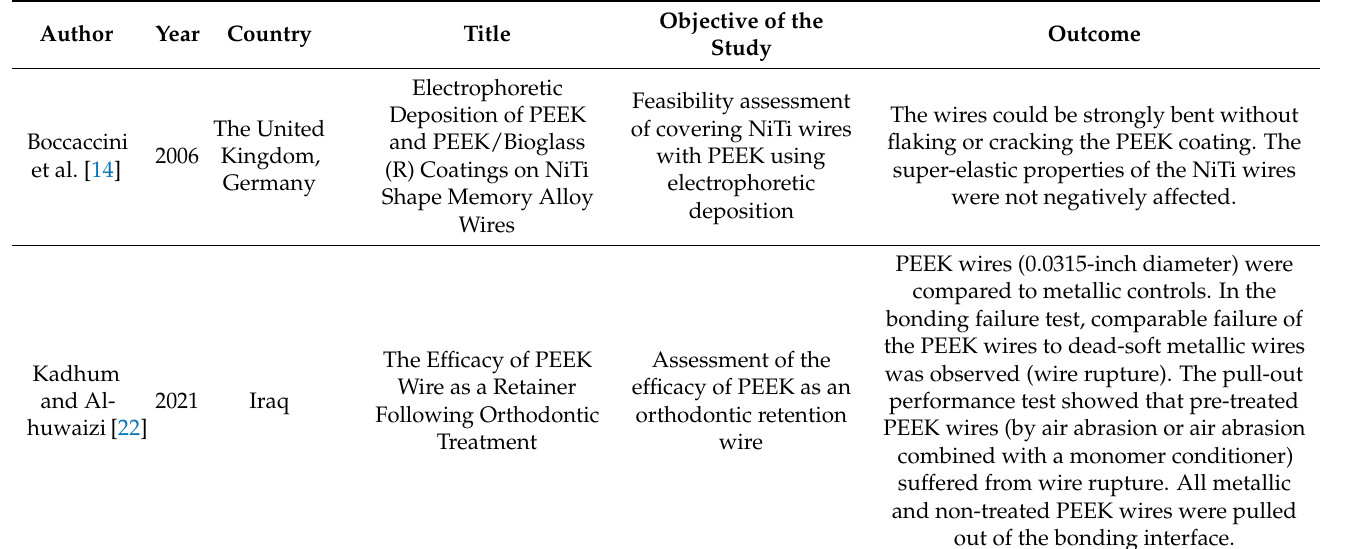
Table 3. Main properties of included